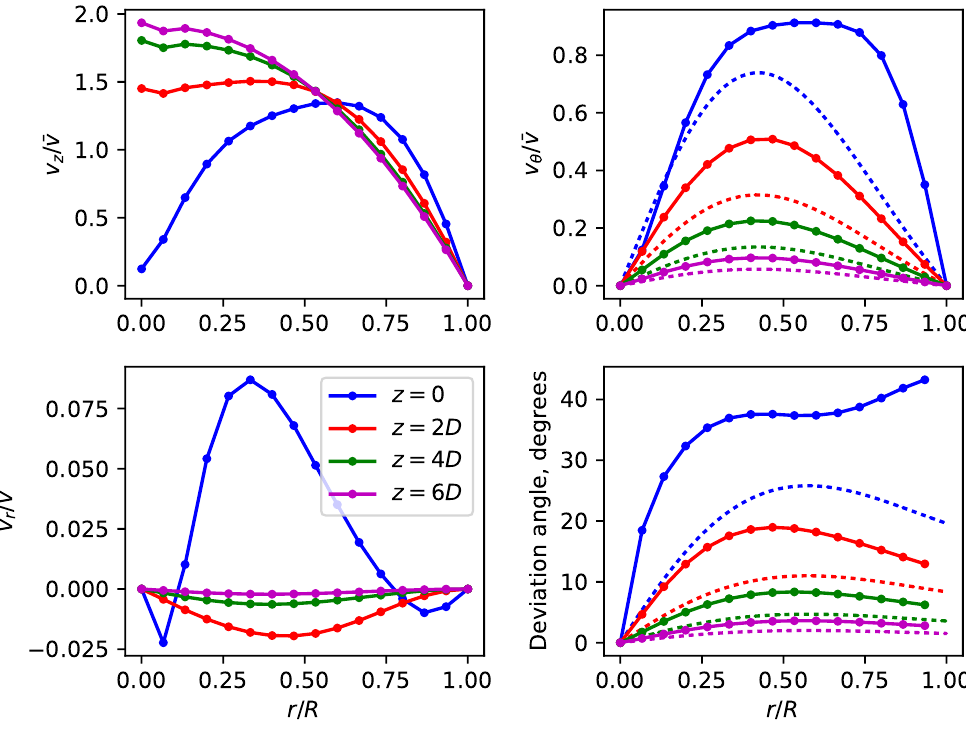
Figure 18. Axial ( z , upper left ), tangential ( θ , upper right ) and radial ( r , lower left ) velocities averaged for each radius in four cross sections. On the lower right , the deviation angle of the flow is shown. The dotted lines indicate theoretical profiles according to the results from [17] with the same swirl number as used in this study ( S =